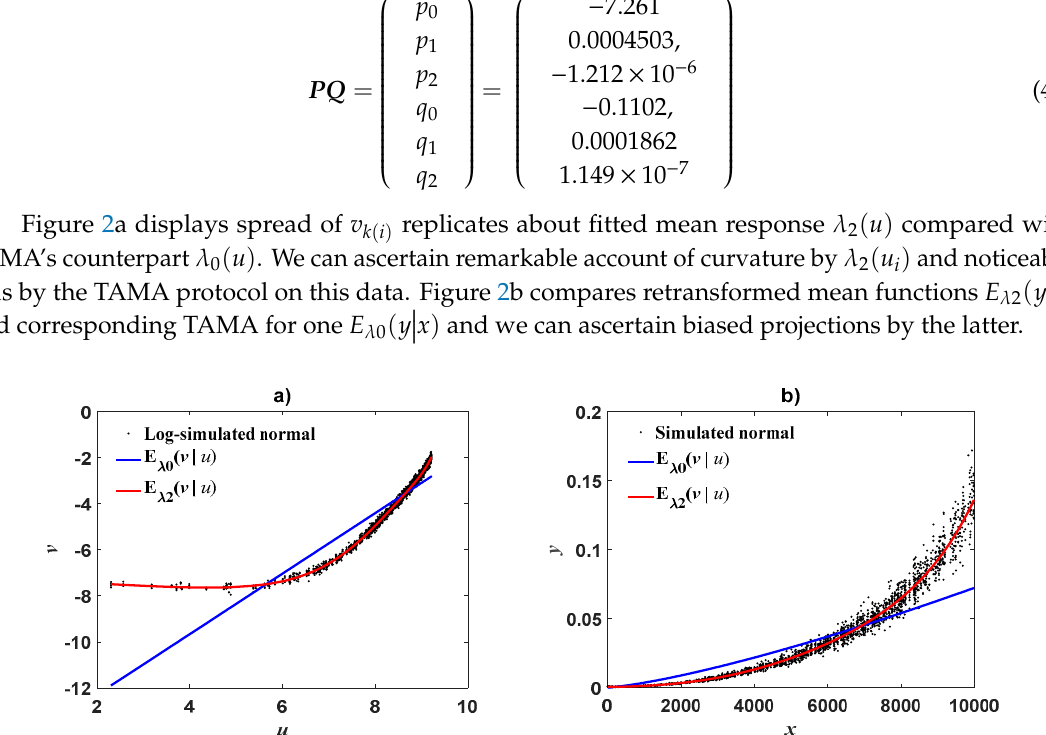
Table 1. Performance metrics for addressed proxies fitted on data simulated by the procedure of Equation (43) (non–normal errors). 𝐸 (cid:3090)(cid:2868) (𝑦|𝑥) stands for back transformed TAMA, 𝐸 (cid:3090)(cid:2870) (𝑦|𝑥) is for back transformed 𝜆 (cid:2870) (𝑢) form. Huxley–DNLR refers to Huxley’s model fitted by direct non-linear regression, Η (cid:3021)(cid:3020)(cid:3012) (𝑥) stands for the direct scales Takagi–Sugeno–Kang (TSK) fuzzy model regression protocol of Equation (34). 𝐸 (cid:2960)(cid:3021)(cid:3020)(cid:3012) (𝑦|𝑥) denotes bactransformed form of the geometrical space TSK form Ω (cid:2904)(cid:2903)(cid:2895) (𝑢). Finally, 𝐸 (cid:3095)(cid:3040) (𝑦|𝑥) , associates to back transformation of 𝜋 (cid:3040) (𝑢) a direct polynomial representation of MCA in geometrical scales. AIC stands for Akaike’s information criterion, 𝛒 symbolizes Lin’s concordance correlation coefficient, R 2 denotes determination coefficient, SEE standard error of estimation and MPE mean prediction error.